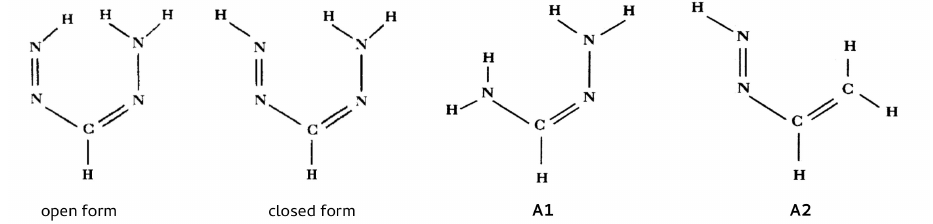
Figure 16. The open and closed forms of formazan and the two reference systems ( A1 and A2 ) used by Buemi et al. [67] in